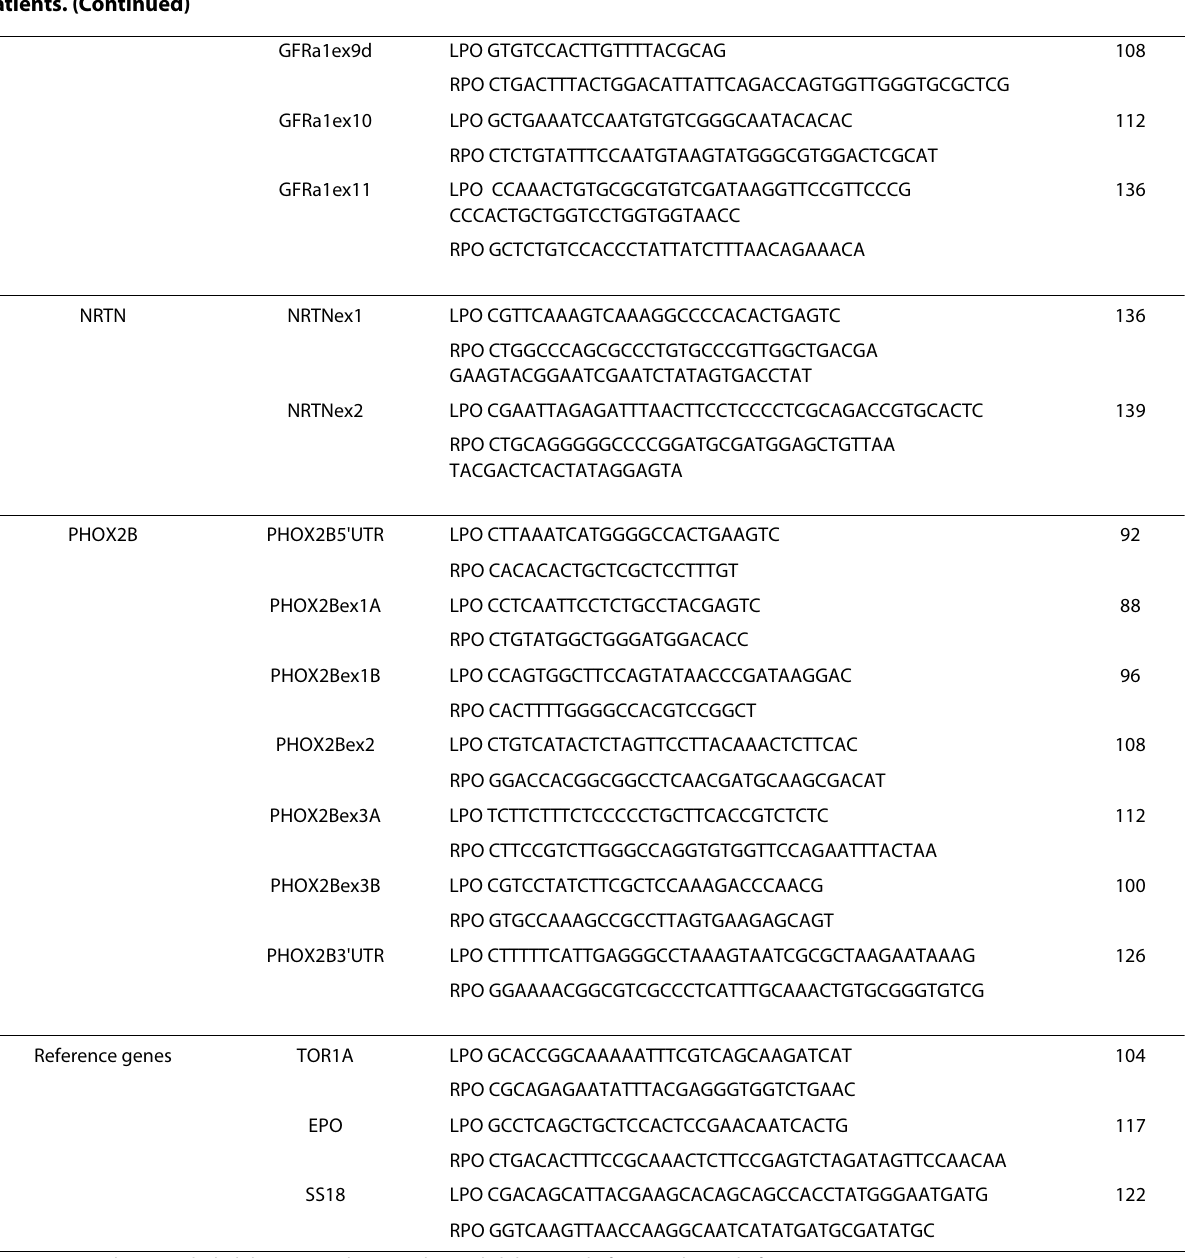
Table 1: Self-designed MLPA probes used in the molecular analysis of EDNRB, GFRa1, NRTN and PHOX2B CNVs of 208 HSCR patients.